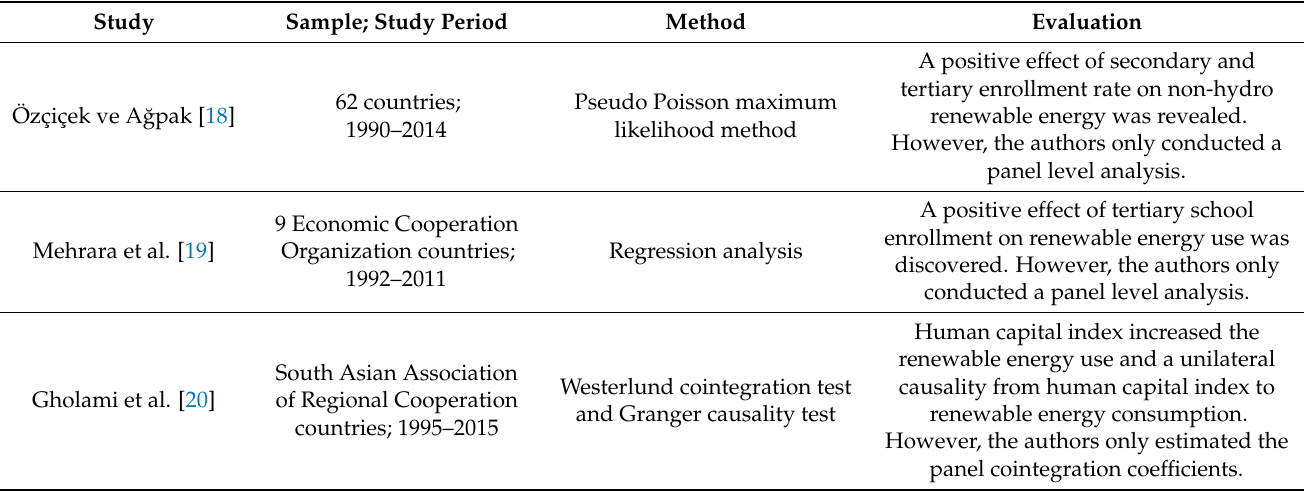
Table 1. Literature summary about the nexus between educational attainment/human development and renewable energy